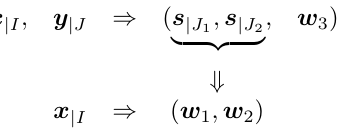
Figure 3: Overview of the simulation